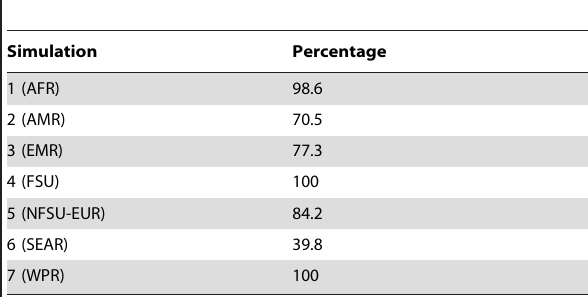
Table 4. The percentage of simulations in which the correct tree structure is chosen.